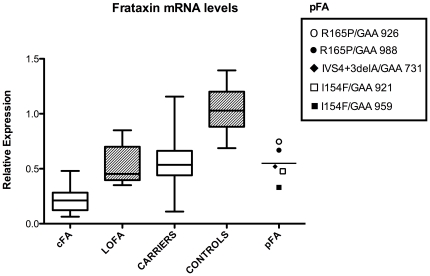

FXN mRNA levels in PBMC.Box and wiskers plots (min to max) of FXN mRNA relative expression levels in cFA (n = 23), LOFA (n = 6), carriers (n = 29), controls (n = 25), and pFA (n = 5). Statistical significance for all groups compared to controls is p<0.0001.